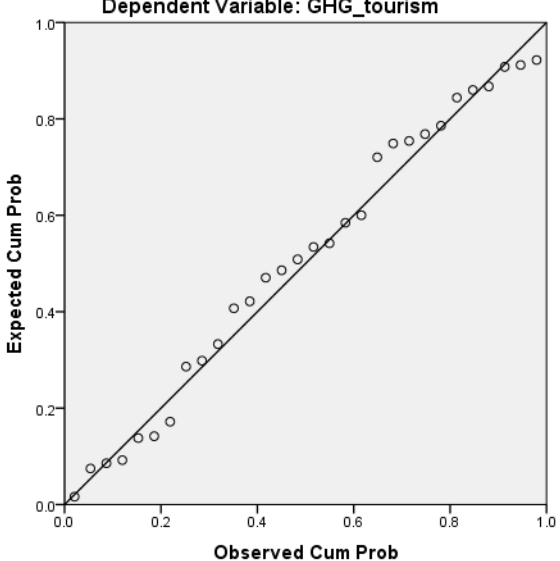
Figure 6. Normal P-P plot of regression standardized residuals. Source: Authors’ own contribution, based on data provided by EUROSTAT.